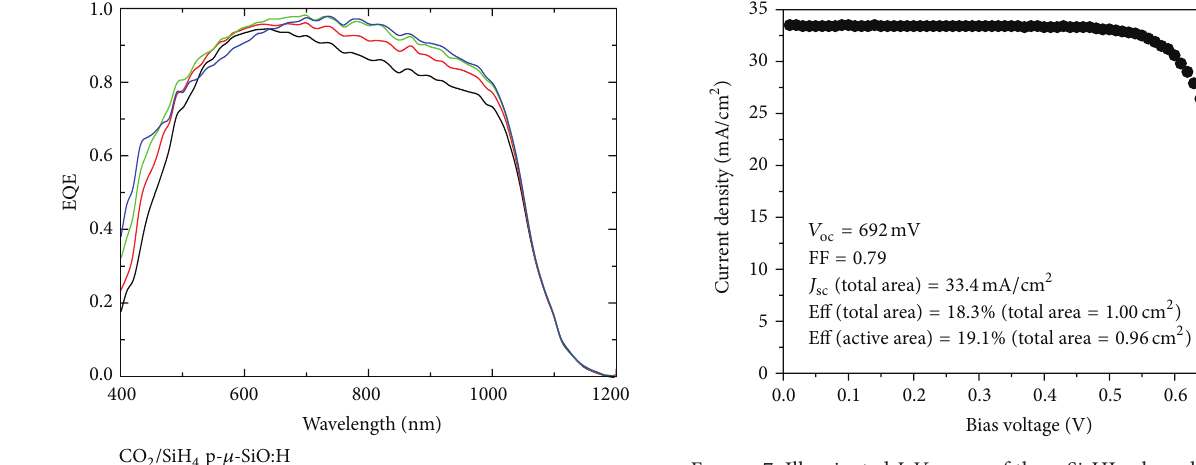
Figure 7: Illuminated J - V curve of the c-Si-HJ solar cell using the optimized p- 𝜇 c-SiO:H emitter